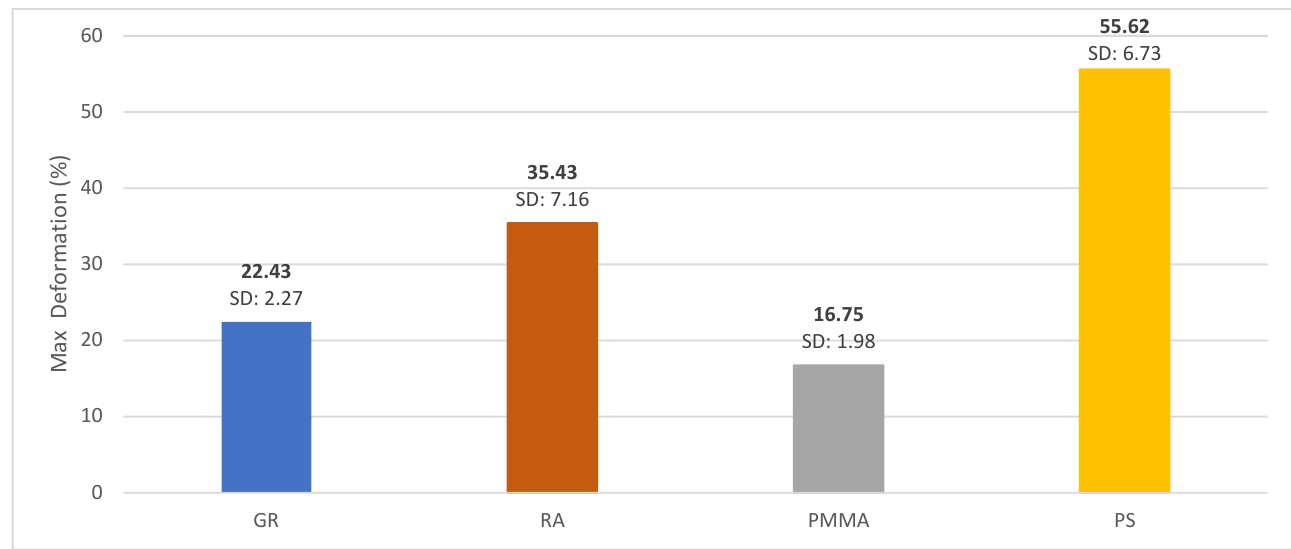
Figure 6. Force-displacement curves of the different materials analyzed: ( a ) PMMA; ( b ) GRA; ( c ) RA; ( d ) PS.